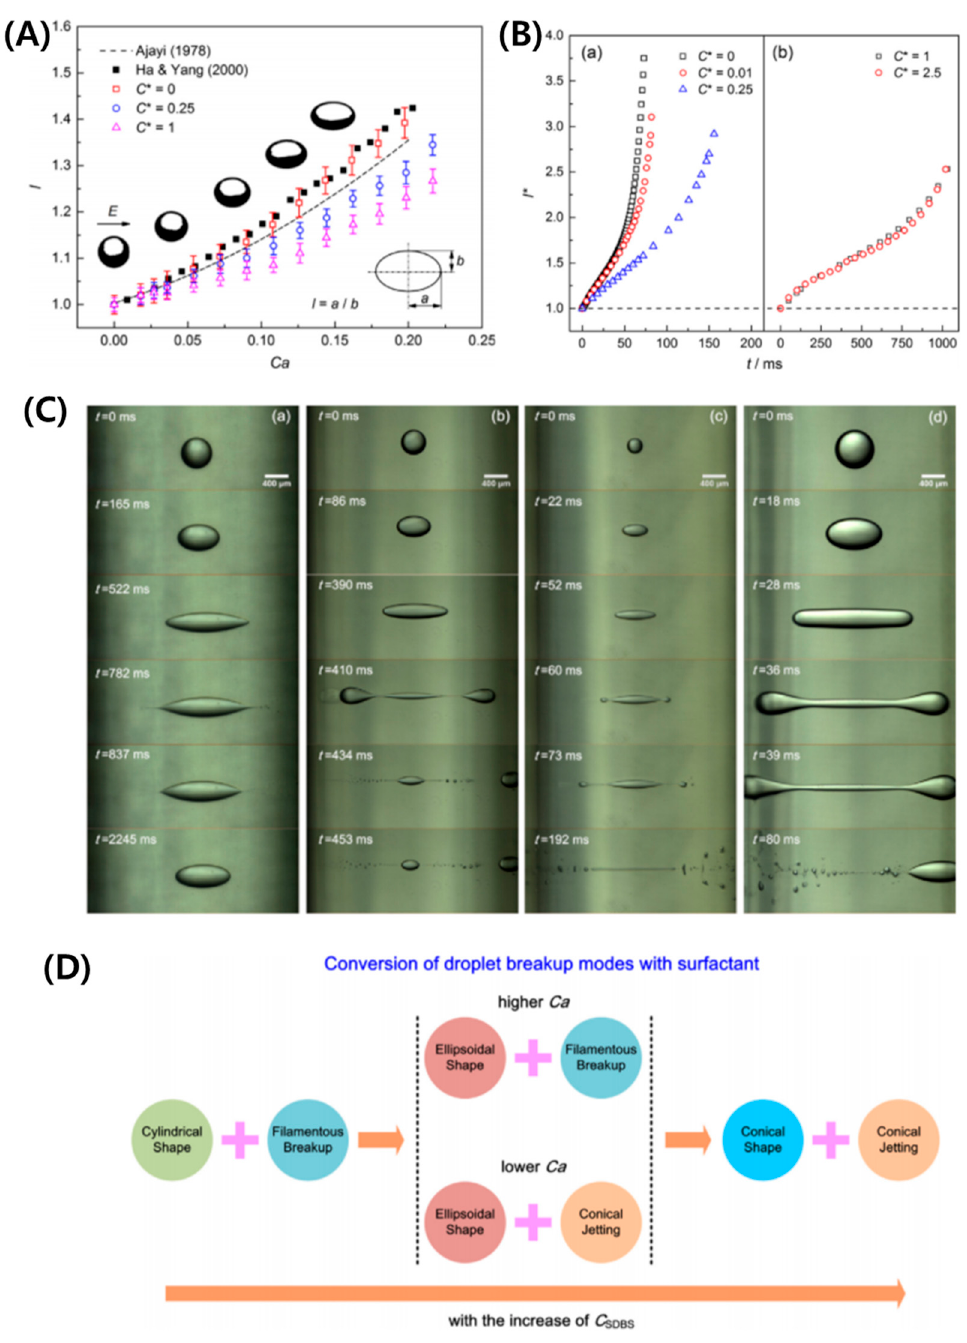
Figure 7. Surfactant-laden droplets under a DC electric field. ( A ) Steady deformation represented by degree of stretching ( l ) vs. electric capillary number ( Ca E ) at di ff erent surfactant concentrations ( C ∗ ). ( B ) Stretching dynamics [27]. ( C ) Breakup modes. ( D ) Conversion between breakup modes [83] .